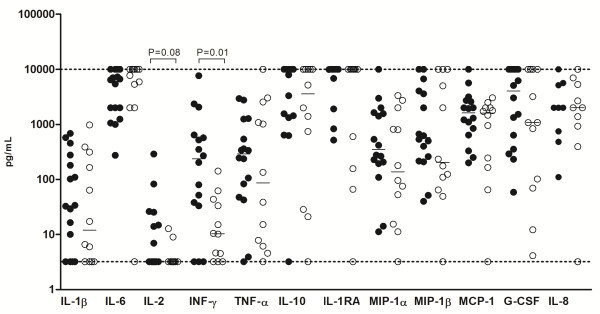
Comparison of cyto/chemokines levels in CSF from S. pneumoniae and N. meningitidis patients. S. pneumoniae patients showed similar levels of cyto/chemokines compared to N. meningitidis patients, except for IFN-γ (P < 0.05 by Mann Whitney test). IL-8 shows a lower number of samples due to CSF availability. Dotted lines mark the upper and lower limits of detection.